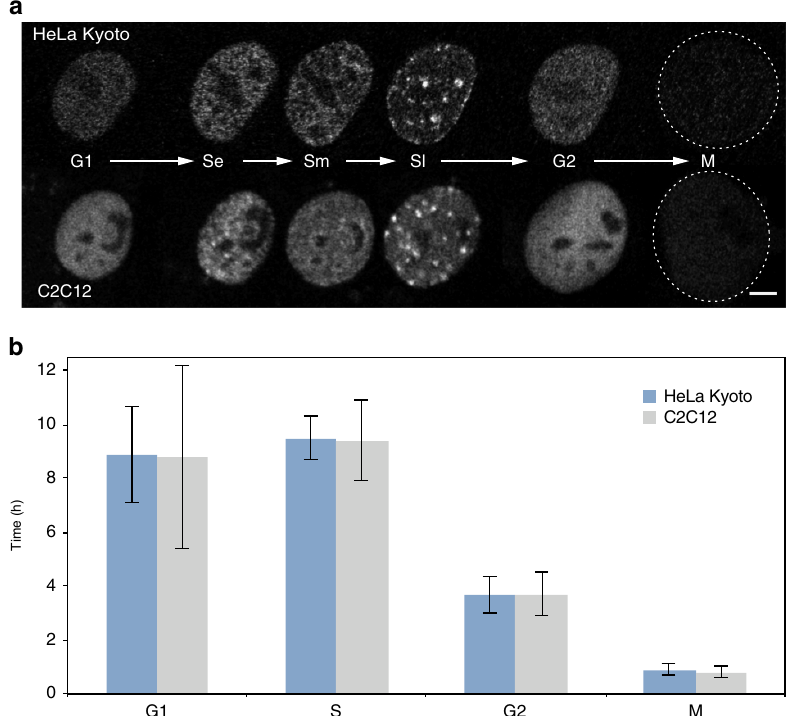
Figure 1 | Direct measurement of cell cycle kinetics. ( a ) Patterns of PCNA distribution in all cell cycle stages imaged with live-cell time-lapse microscopy of human HeLa Kyoto (top) and mouse C2C12 cells (bottom). S-phase stages are further subdivided into early (Se) mid (Sm) and late (Sl). ( b ) Duration of the cell cycle phases (mean ± s.d.; additional data in Table 1) measured from time-lapse microscopy analysis as shown in a (see also Supplementary Movie 1). Error bars represent s.d., number of replicates for human cells G1: 31, S: 30, G2: 27, M: 26; mouse cell replicates, G1: 20, S: 16, G2: 5, M: 10. Scale bar, 5 m m.